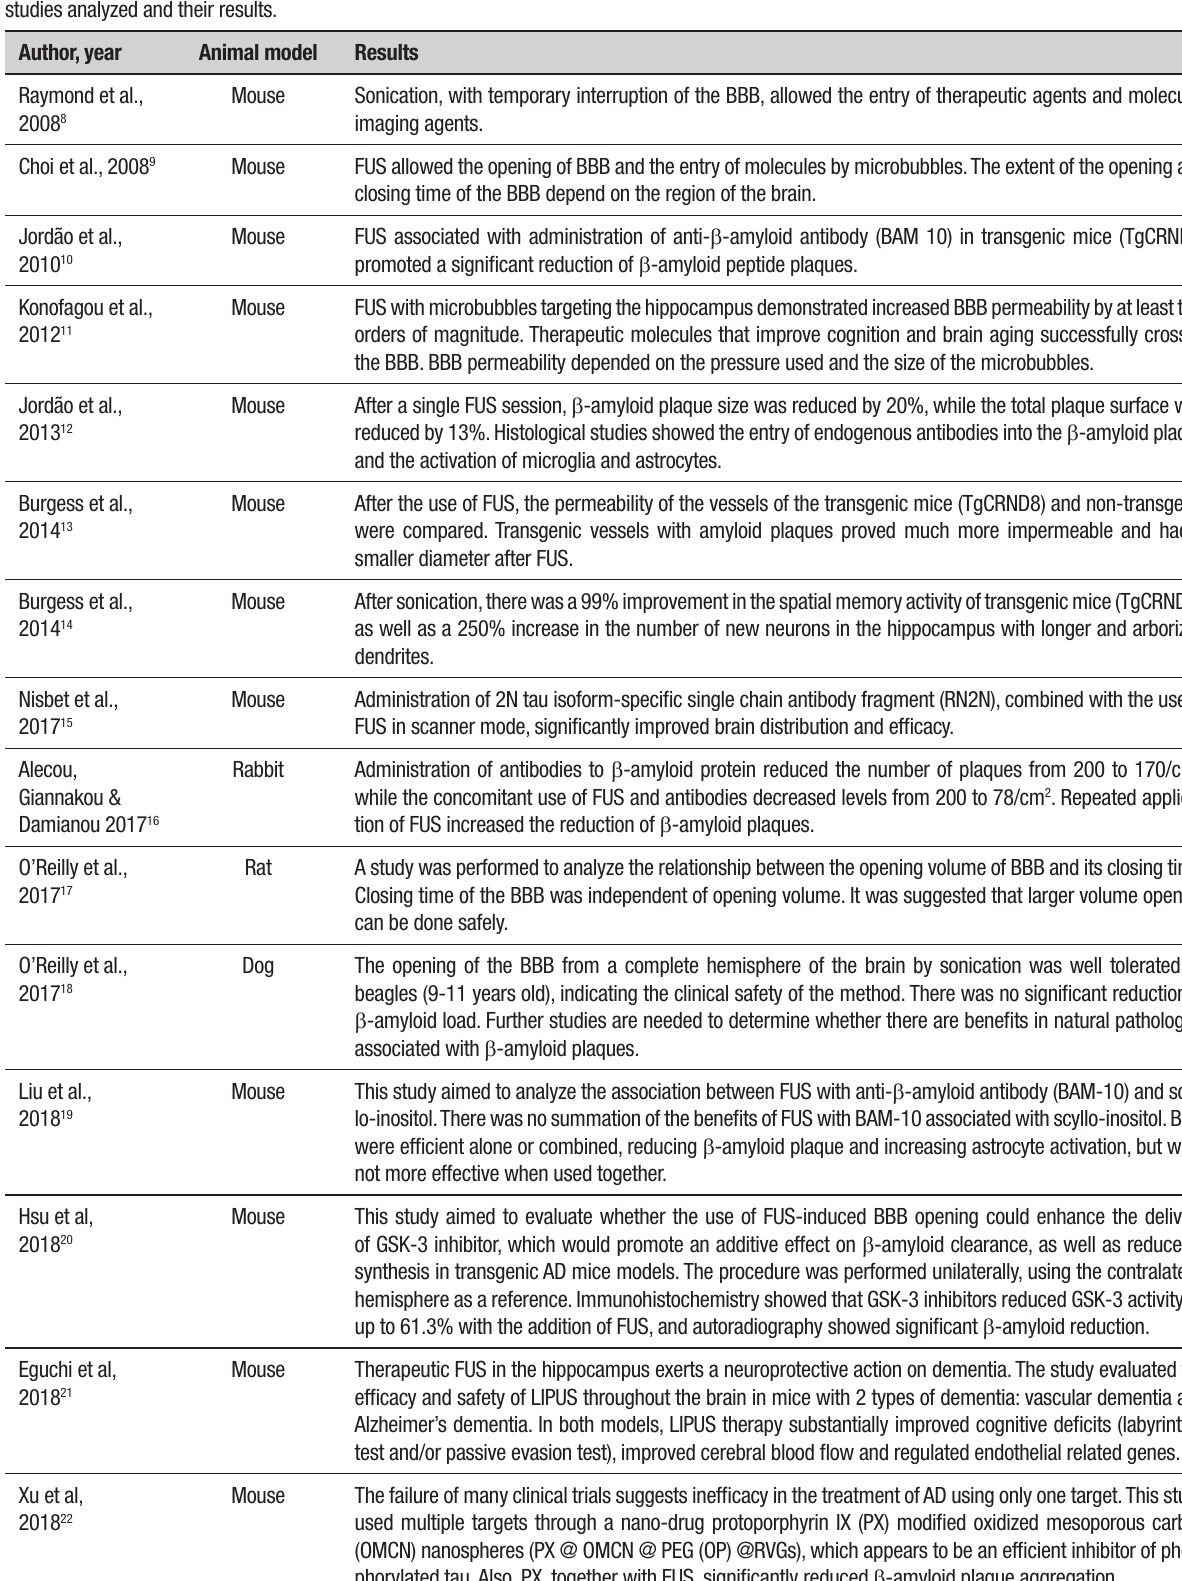
Table 1. The use of focused ultrasound (FUS) to open the blood-brain barrier (BBB) in the treatment of Alzheimer’s disease (AD): a list of pre-clinical studies analyzed and their